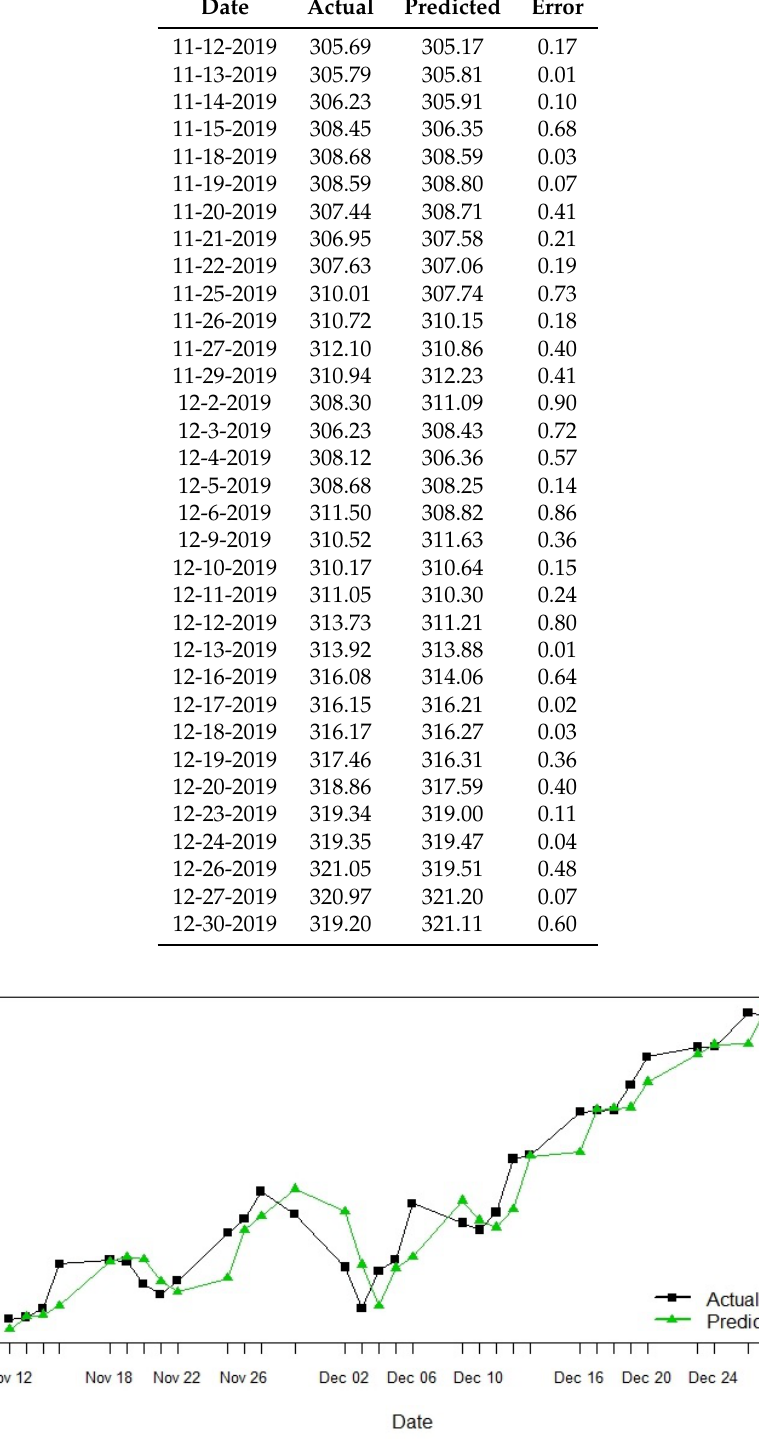
Figure 8. Stochastic model geometric Brownian motion